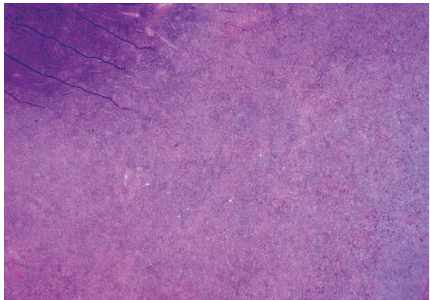
Figure 1: Low-power view of the left inguinal lymph node biopsy demonstrating complete effacement of normal lymph node architecture.